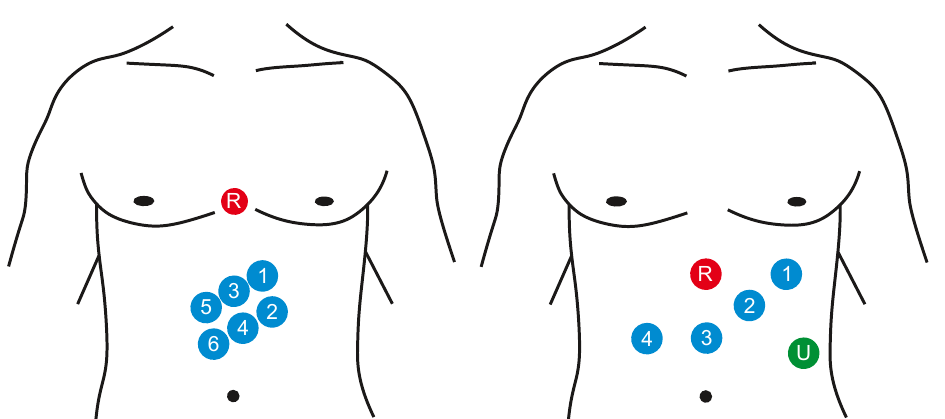
Figure 6. Examples of the surface placement of the EGG electrodes: signal electrodes (1–6), reference electrode (R), and ground electrode (U).